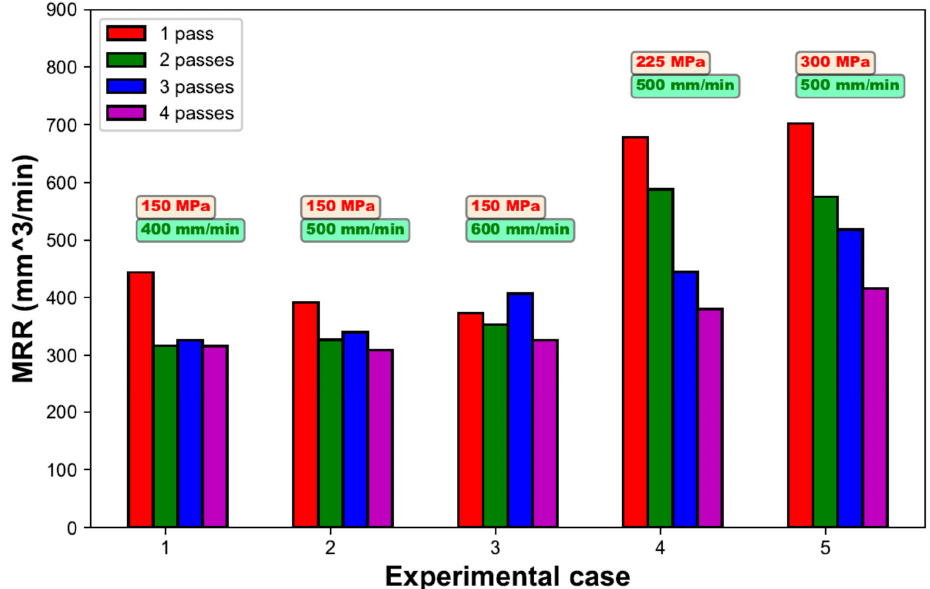
Figure 9. Variation of MRR for the increasing number of passes and different process conditions.